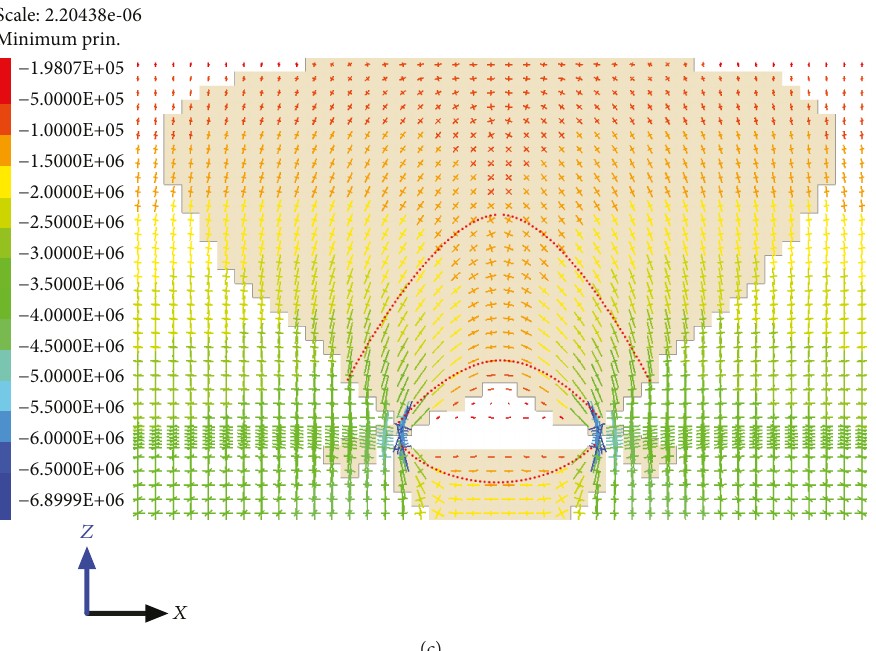
Figure 8: Vector fi eld of the principal stress in the surrounding rock. (a) Initial mining stage. (b) The pressure arch in the near fi eld. (c) The pressure arch in the far fi